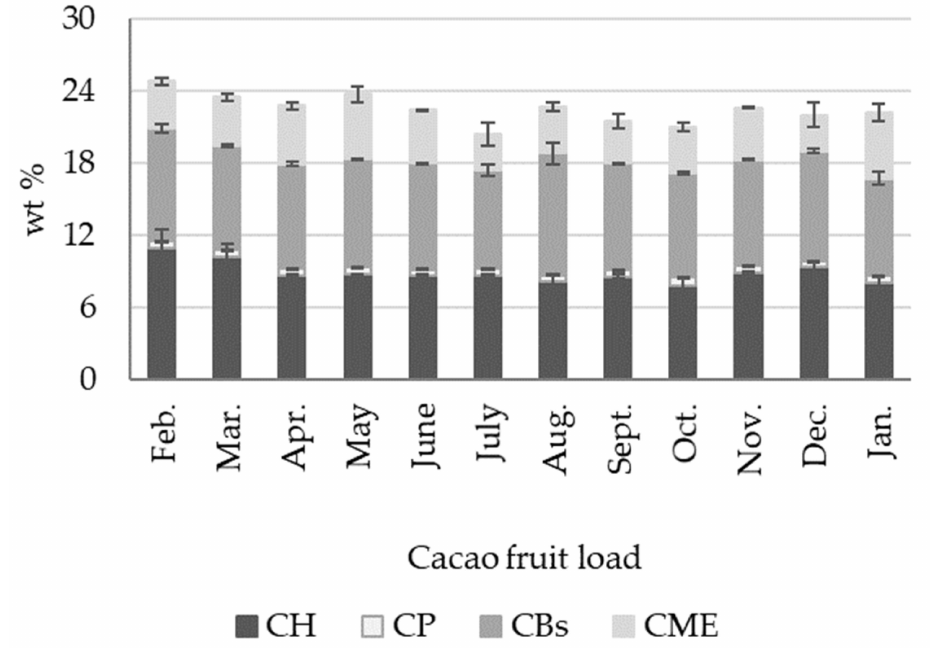
Figure 4. Seasonal variations in the percentage weight of cacao fruit biomass outputs, dried cacao husk (CH), dried cacao placenta (CP), dried cacao beans (CBs), and liquid cacao mucilage exudate (CME) derived from the second stage of cacao fruit processing (Figure 3). Note: the remaining percentage corresponds to